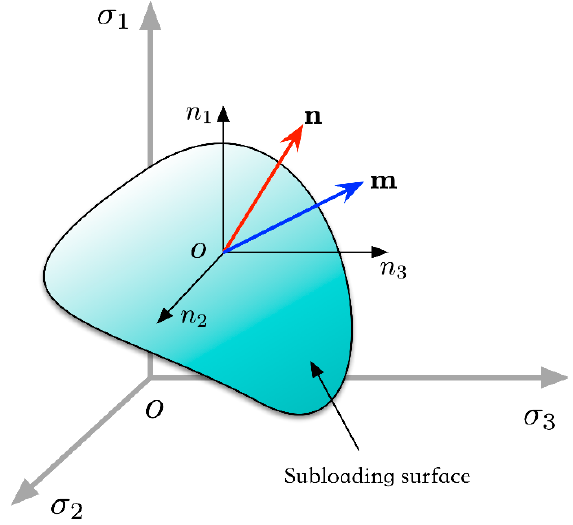
Figure 1. The schematic of the fractional-order flow rule.